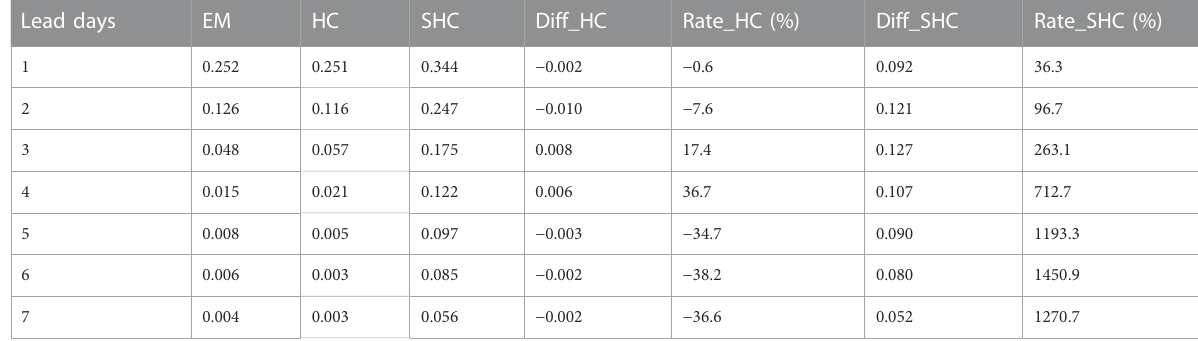
TABLE 3 Same as Table 1, but for TS related to 100 mm precipitation (order of magnitude: 10 − 1